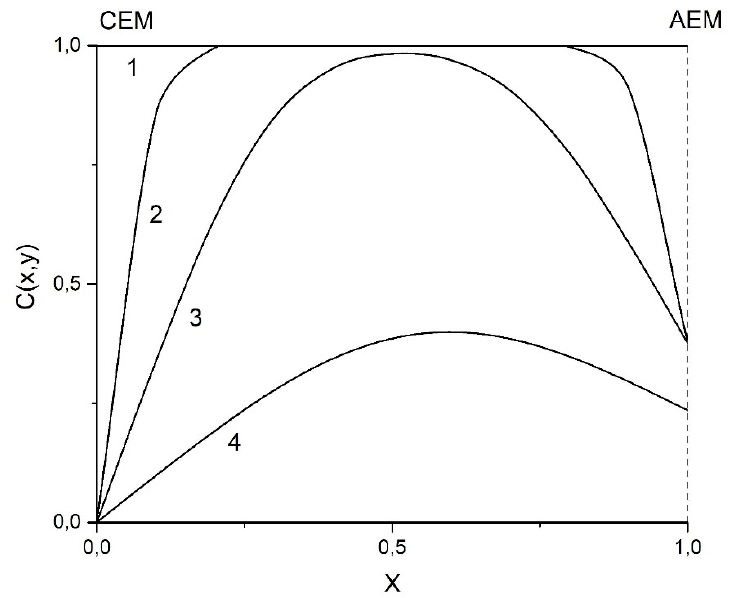
Figure 9. Concentration profile in the DC of an ED cell computed (at = 0.2 V) using the basic version of convection-diffusion model [247–249] at different dimensionless distances from the channel entrance (cid:0) (cid:1) Y = yD / Vh 2 : 1 – 0, 2 – 0.001, 3 – 0.02, 4 – 0.2. AEM and CEM refer to an AEM and a CEM,